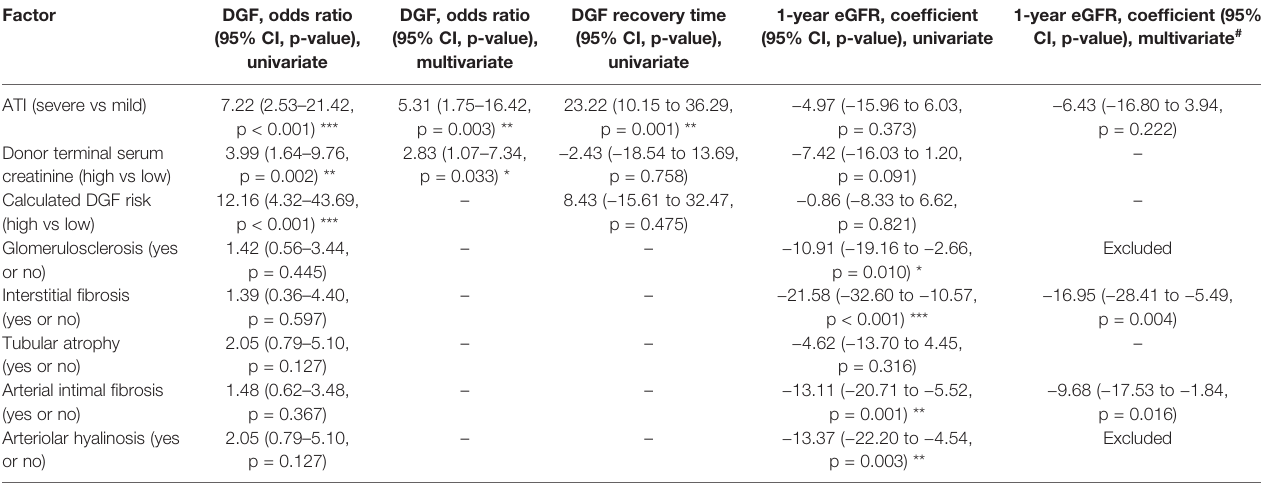
TABLE 5 | Univariable and multivariable analyses of pathological factors affecting DGF and 1-year eGFR.